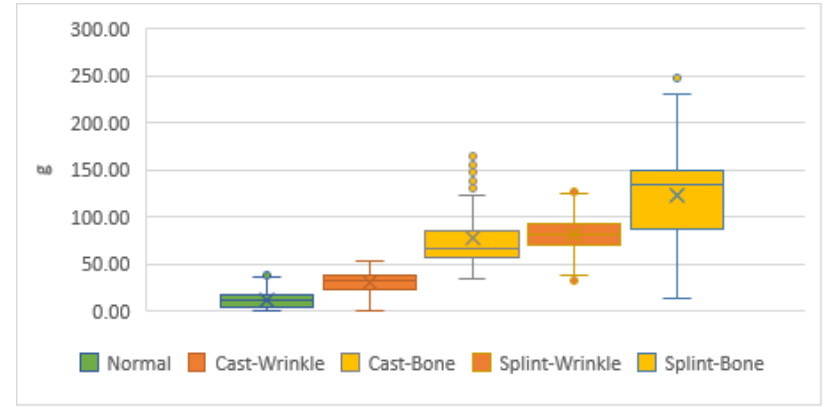
Figure 6. Actual test simulation of the pressure on the arm in the form of a short arm-cast and a short arm-splint.